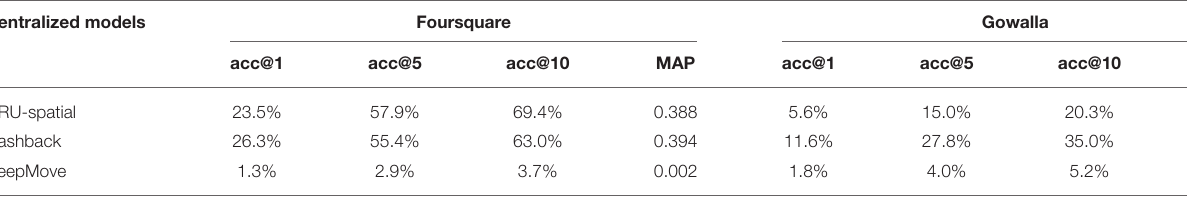
TABLE 2 | Centralized results.